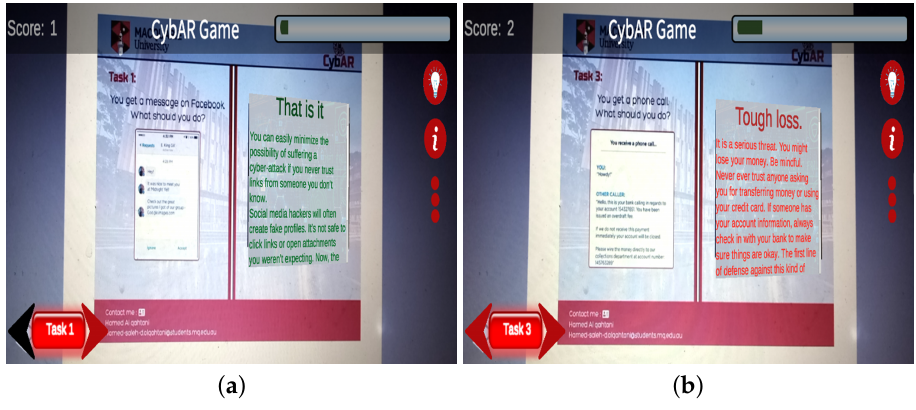
Figure 4. ( a ) Correct answer feedback. ( b ) Wrong answer